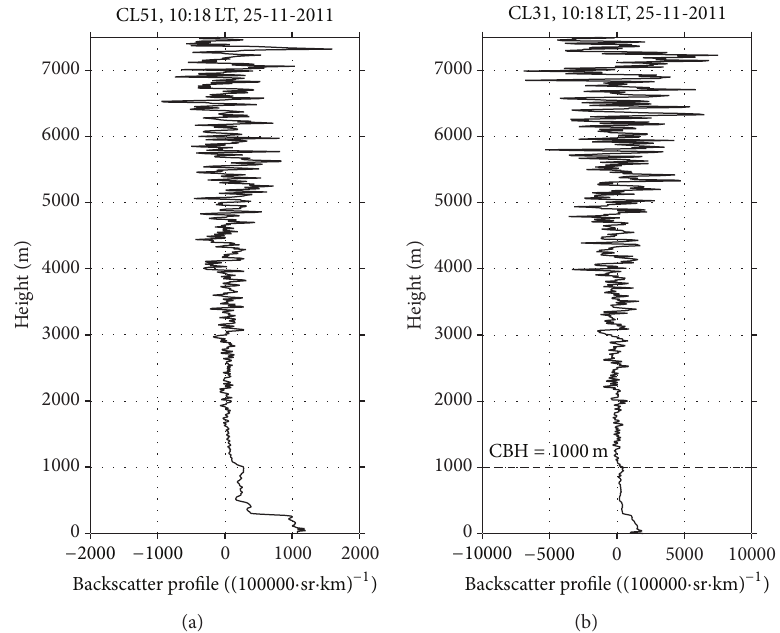
Figure 2: Vertical profiles of the attenuated backscatter coefficient from both ceilometers (25 November 2011): (a) Vaisala CL51 and (b) Vaisala